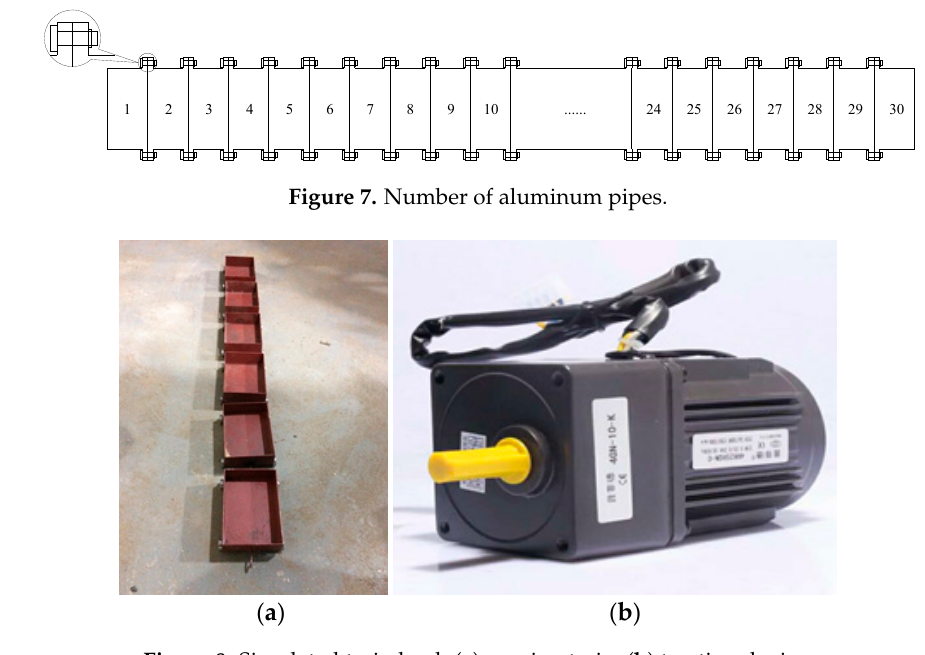
Figure 9. Simplified finite element model.